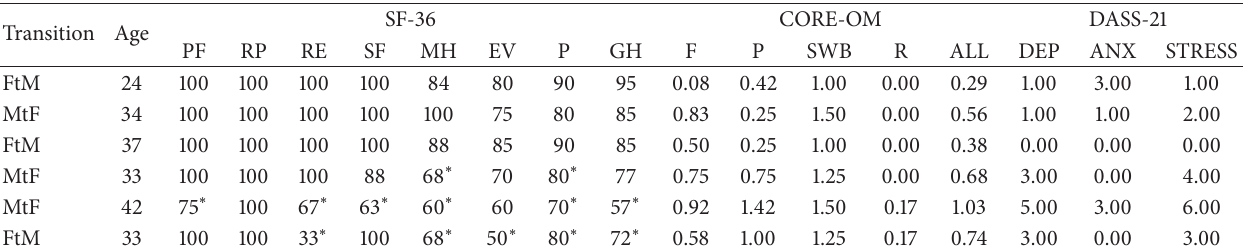
Table 2: Results on CORE-OM, SF-36, and DASS-21 for each participant ( 𝑁 = 6